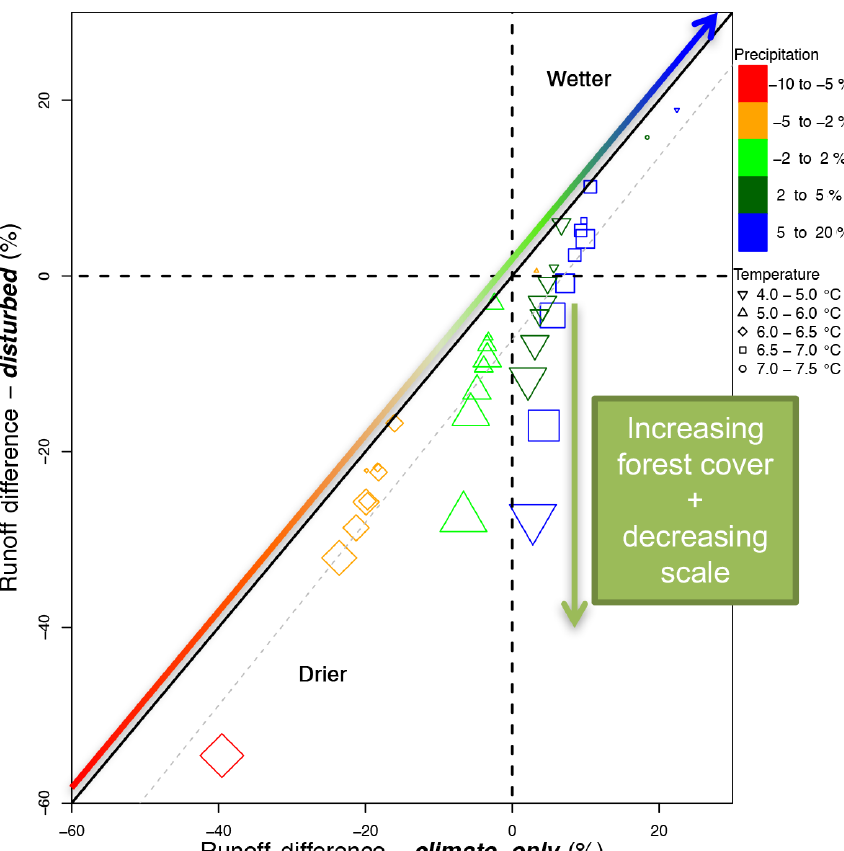
Figure 5. Runoff differences for the climate-only scenario ( x axis) plotted against disturbed scenario ( y axis). Increasing sizes indicate results from the entire San Juan River basin (smallest), to all forests (next largest size), and then forests with greater than 10, 50, 70, and 90% coverage (largest). All changes are shown as projected differences from the historical (in % change).